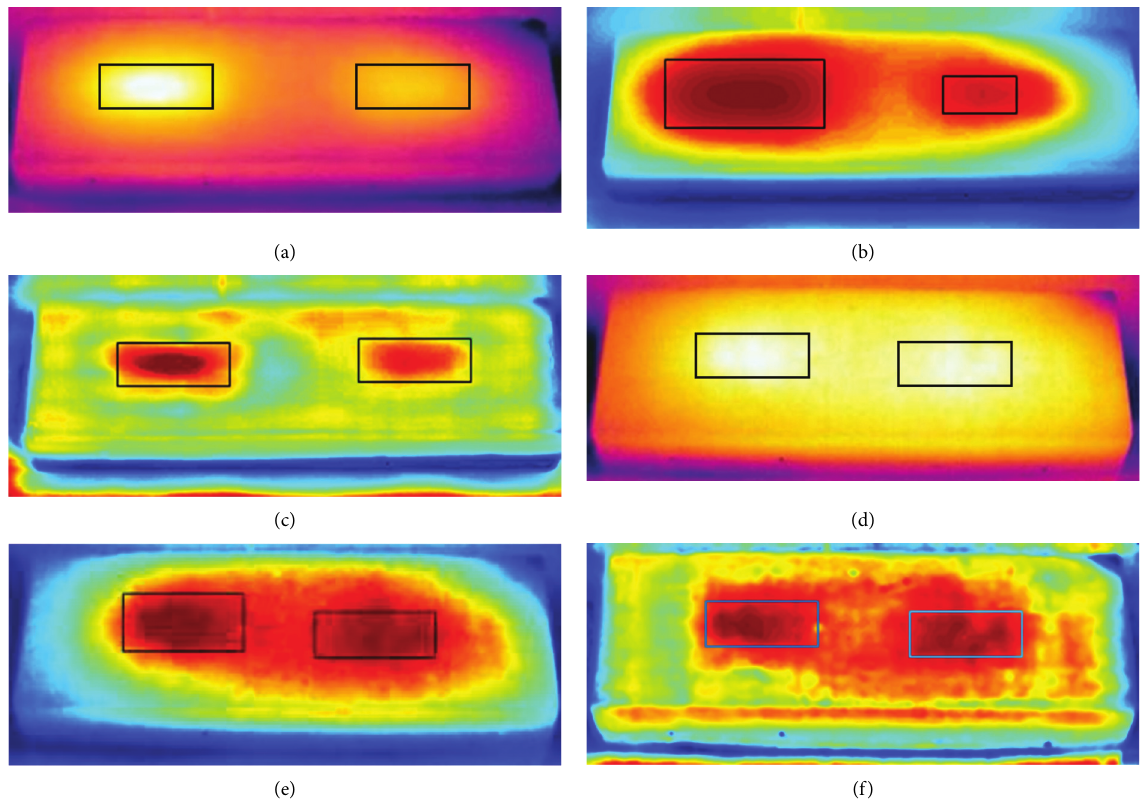
Figure 10: Comparison image enhancement of A1 and A2. (a) A1-before enhancement. (b) A1-GHE enhancement. (c) A1-CLAHE enhancement. (d) A2-before enhancement. (e) A2-GHE enhancement. (f) A2-CLAHE